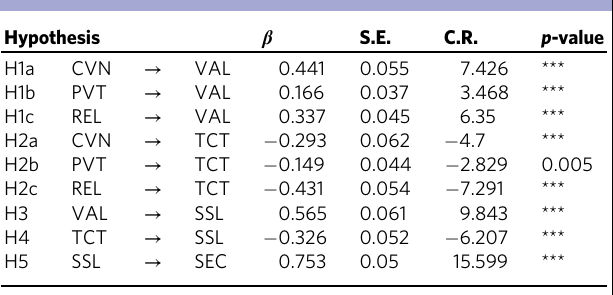
Table 6 Standardised regression